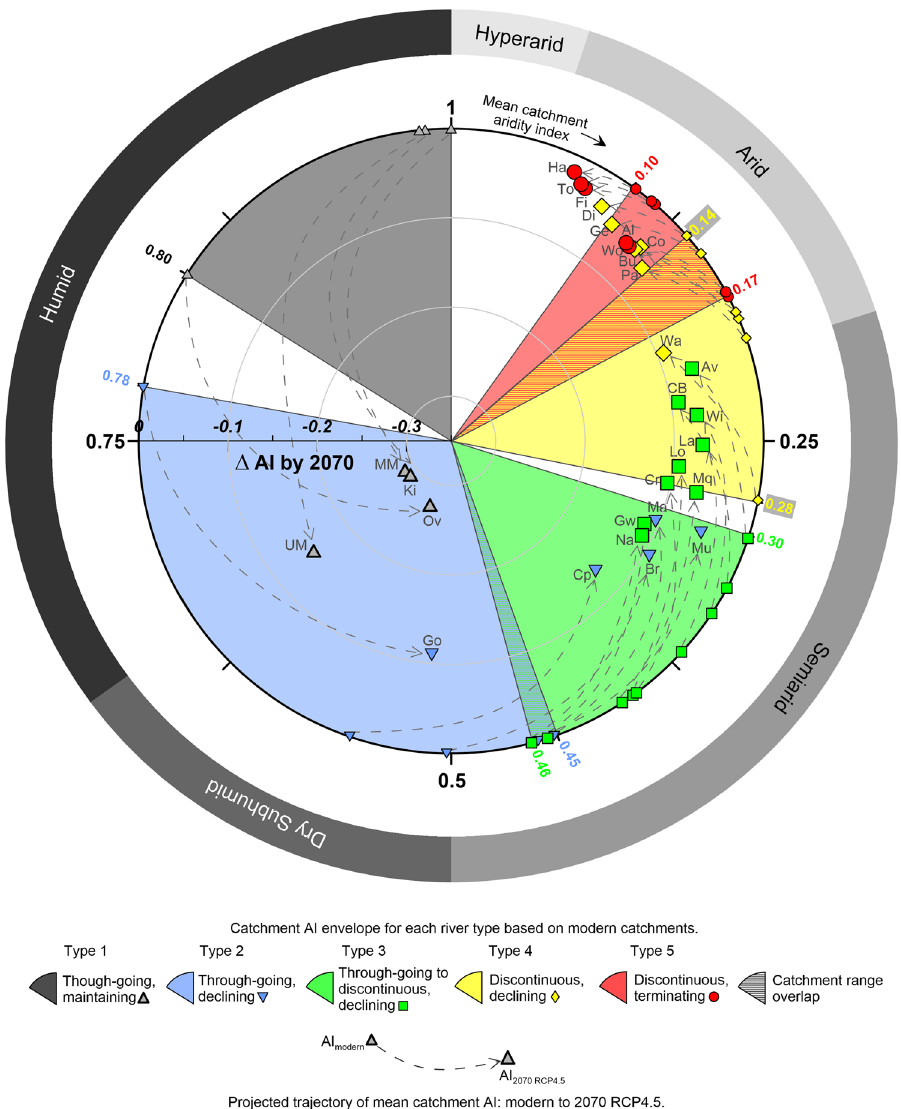
Figure 6. Polar plot displaying the modern and projected mean catchment Aridity Index (AI) value for each catchment (angle axis) and the projected magnitude of change in the mean catchment Aridity Index by 2070 RCP4.5 (radius axis; Δ AI by 2070). Dashed arrowed lines represent trajectories that connect the starting (modern) and end (2070) points for individual rivers; rivers that end closest to the centre of the plot have the largest projected Δ AI. Coloured segments represent the envelope of AI values assigned to each river type based on modern catchment characteristics. Symbols represent the modern river type and those that are a different colour to the underlying segment are rivers that are projected to change river type by 2070 according to RCP4.5. See Fig. 2 for catchment labelling conventions and Table 3 for a list of all